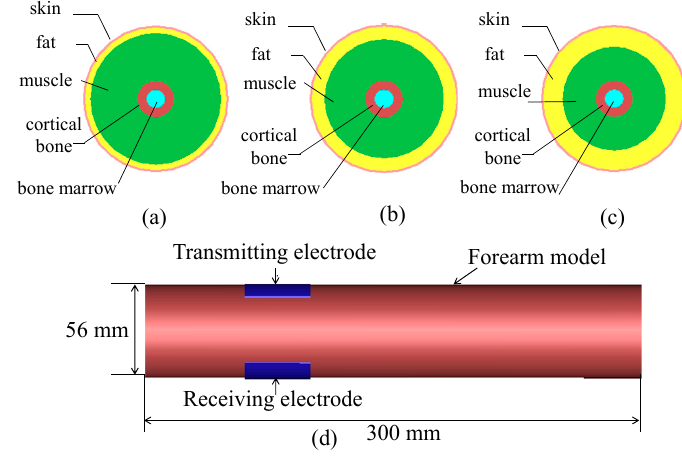
Figure 1. ( a ) The cross-section of Model A; ( b ) the cross-section of Model B; ( c ) the cross-section of Model C; and ( d ) transmitting electrode and receiving electrode. Table 1. Thicknesses of difference tissue layers (mm). Table 1. Thicknesses of difference tissue layers